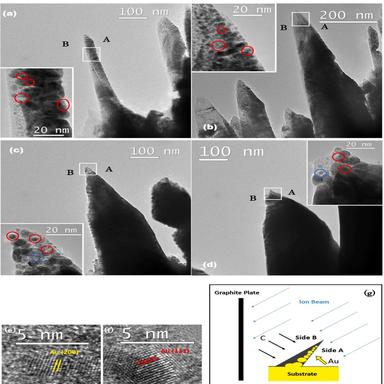
(a-d) TEM Images of AuNPs in typical regions 1 to 4 with the magnified images of the respective rectangles shown in the insets. (e, f) Lattice image of blue and red circles in the inset in (a-d), corresponding to Au (200) and Au (111), respectively. (g) Schematics illustration explaining the origin of the difference in the crystal structure on sides A and B. (For interpretation of the references to colour in this figure legend, the reader is referred to the web version of this article.)